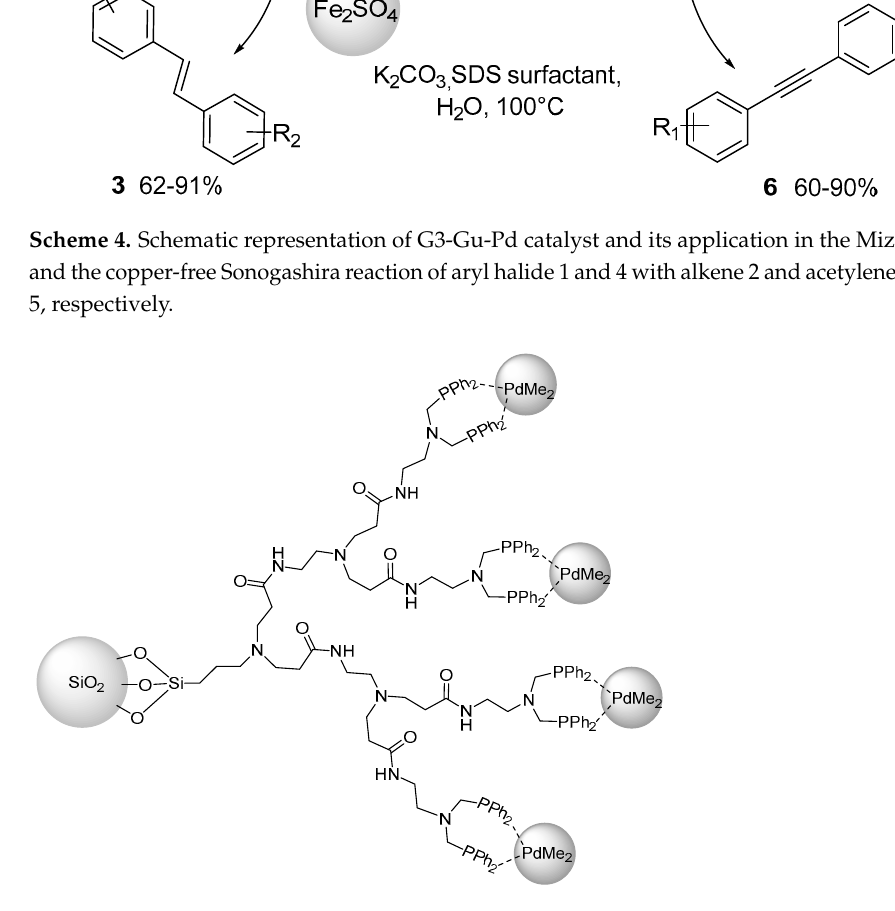
Figure 5. Schematic representation of second-generation silica supported phosphine–palladium terminated PAMAM